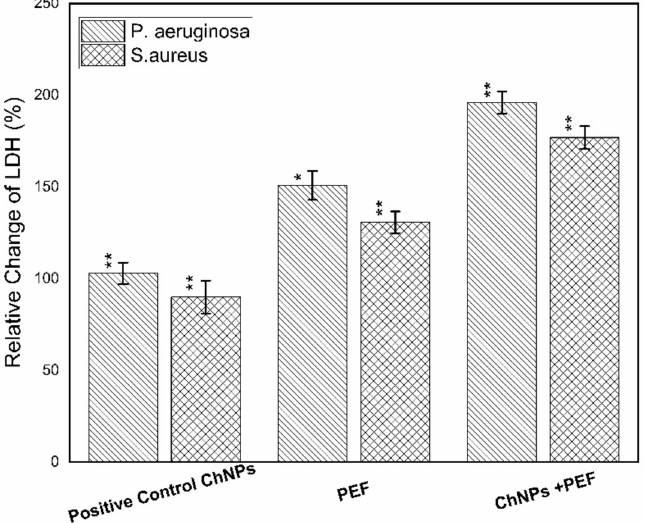
Figure 10. Relative change of LDH percentage for P. aeruginosa and S. aureus samples treated by ChNPs and PEF each alone and combined with exposure to PEF. * statistically significant, ** statisti- cally highly